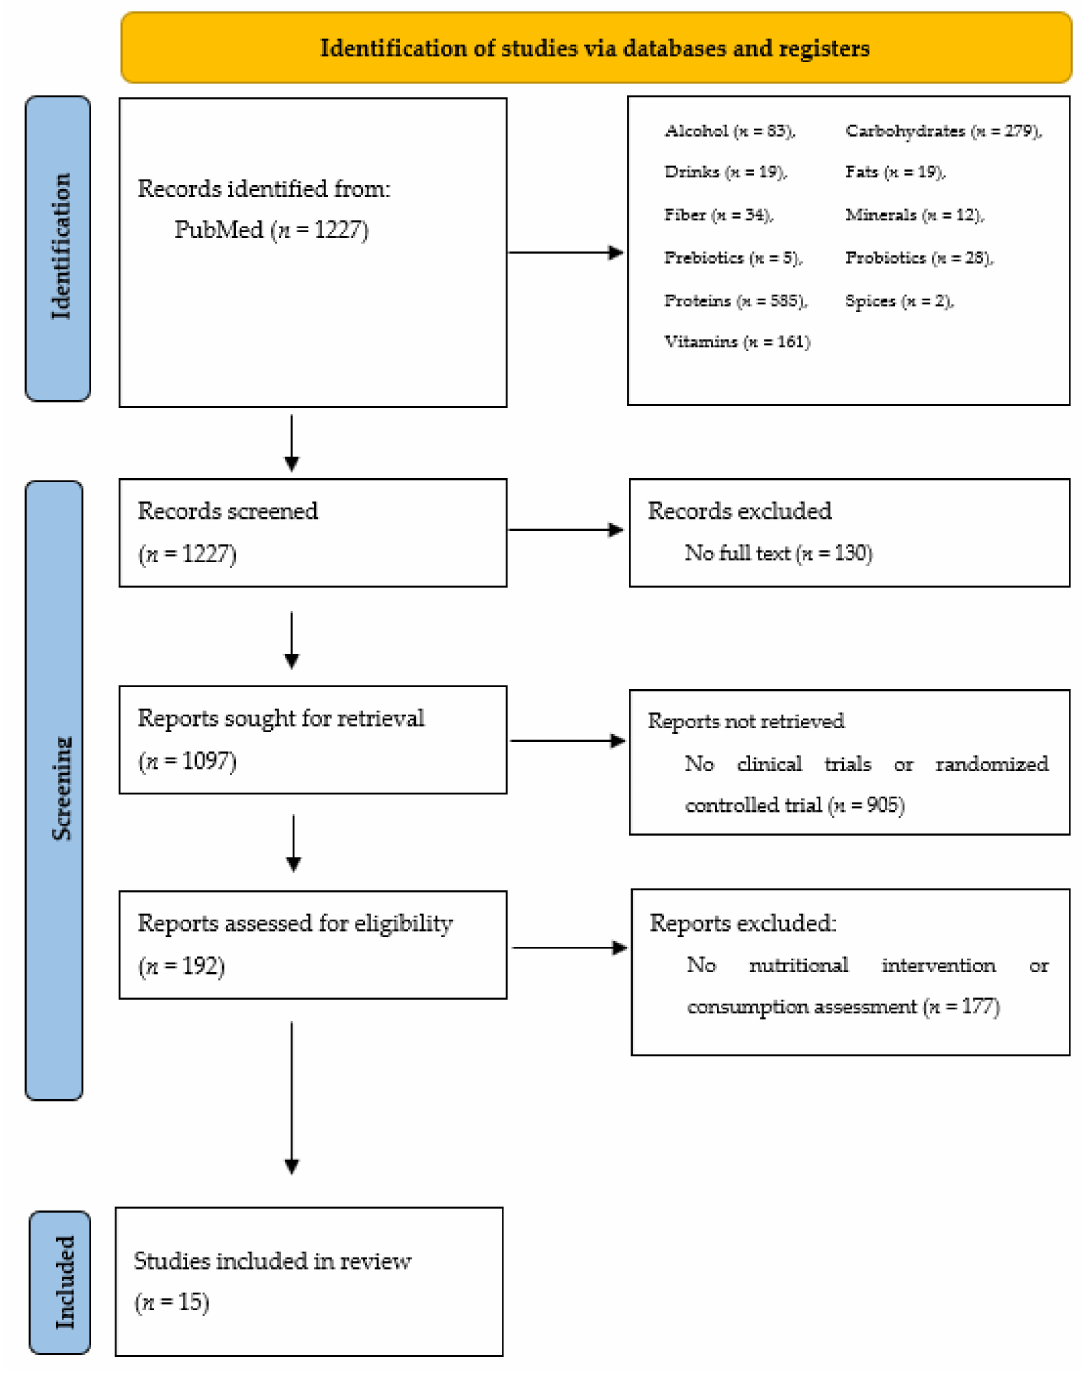
Figure 2. Literature review results, including exclusion